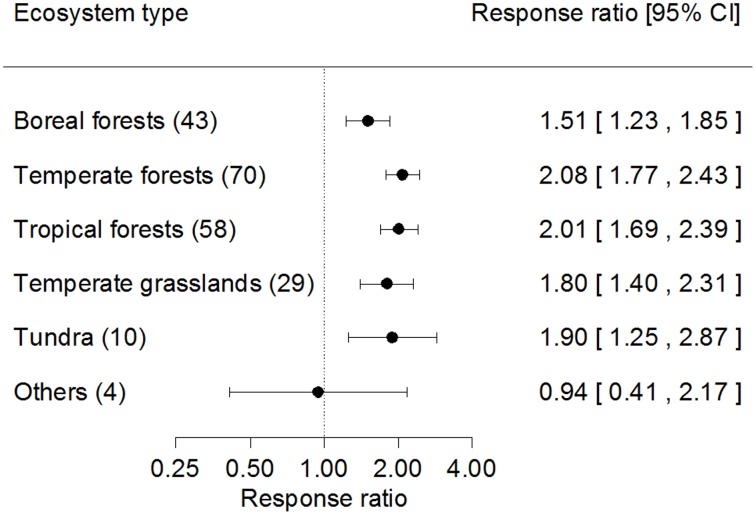
Response ratios for fine root production among ecosystem types.The number in parentheses represents the number of observations. The dot with error bars shows the mean effect size with the 95% confidence interval. The ecosystem of ‘others’ refers to deserts and wetlands.